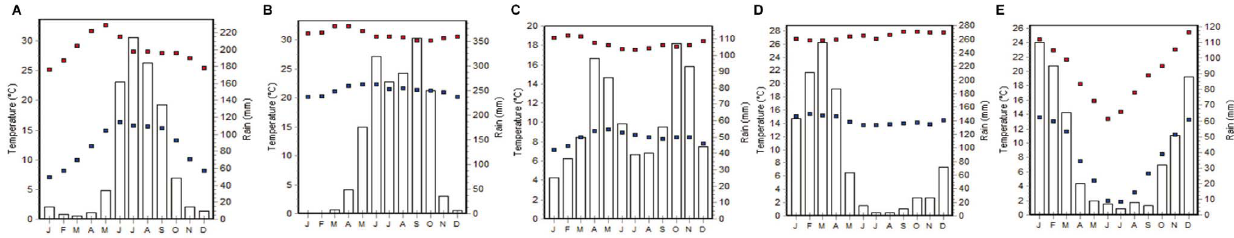
Figure 2. Temporal variation of precipitation (bars), maximum temperature (red squares) and minimum temperature (blue squares) in different representative regions: A. Mexico ( 2 102 6 latitude, 20 6 longitude), B. Guatemala ( 2 90 6 , 14 6 ), C. Colombia ( 2 74 6 , 4 6 ), D. Ecuador-North Peru ( 2 80 6 , 2 4 6 ) and E. Argentina ( 2 65 6 , 2 24 6 ).